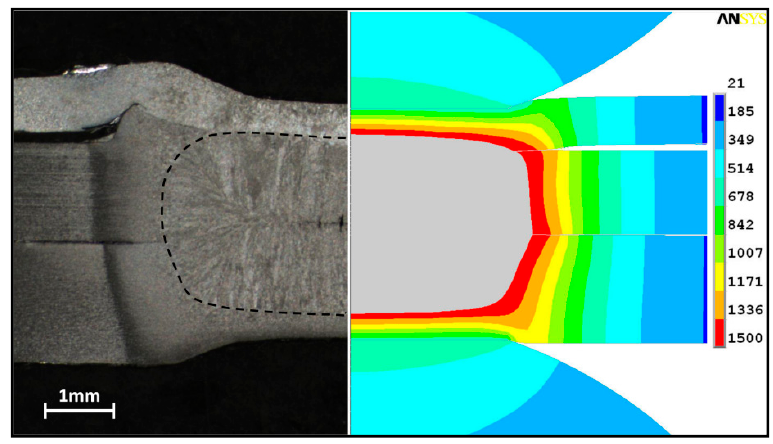
Figure 11. Comparison of the calculated temperature histories between the weld-bonding of Terokal 5089 and the spot welding (Legends in a–d donates the temperature with degree °C). ( a ) weld- bonding @ 20 ms; ( b ) spot welding @ 20 ms; ( c ) weld-bonding @ 240 ms; ( d ) spot welding @ 240 ms; ( e ) Calculated temperature histories of weld-bonding and spot welding.